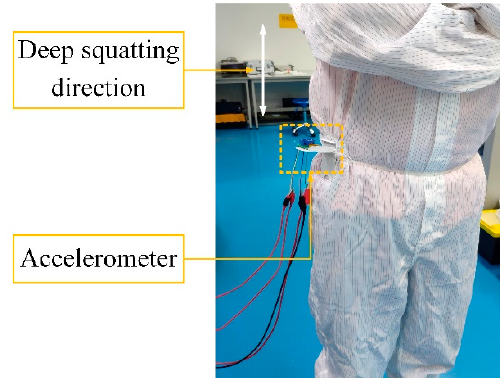
Figure 15. Accelerometer installation for the body motion measurements.